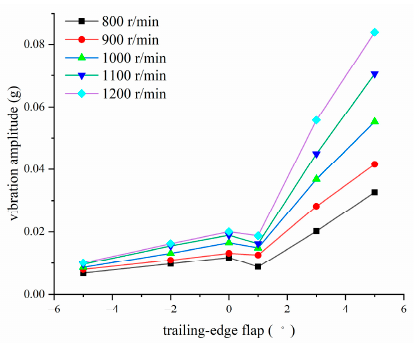
Figure 27. Vertical amplitude diagram of trailing-edge flap.